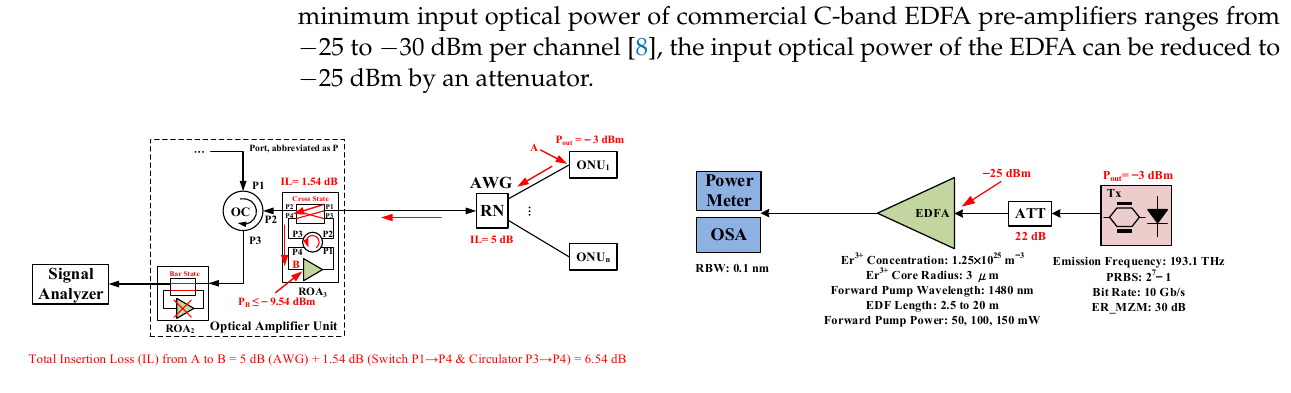
N F ( d B ) EDF Length (m) Figure 11. NF vs. EDF length and gain vs. EDF length at various pumping power values.